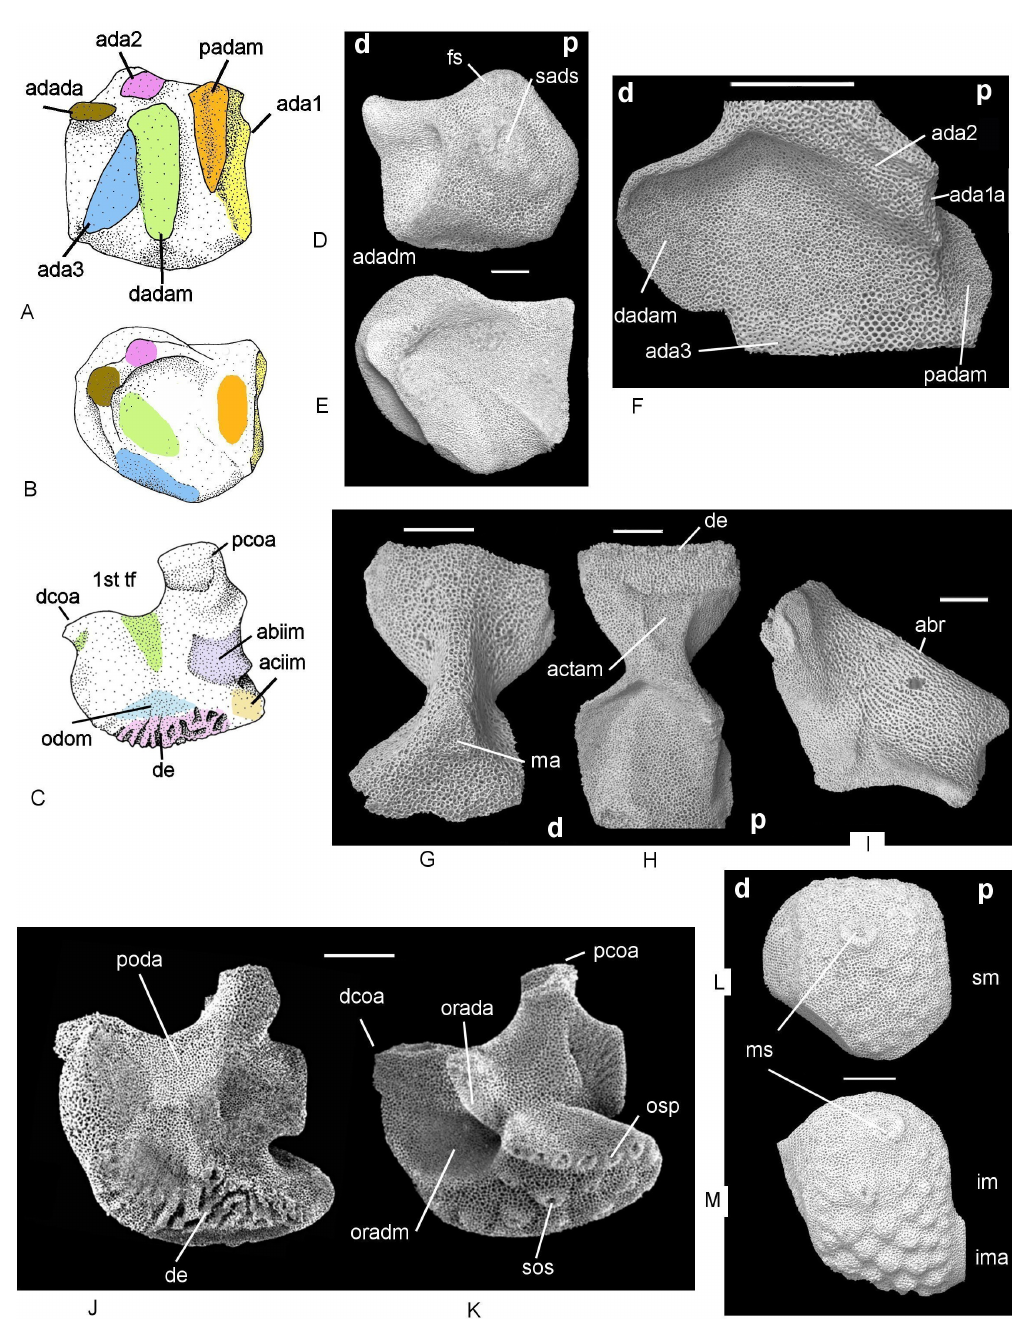
Fig. 3. A–C . Terminology used for adambulacrals and orals in the present paper. A . Actinal view of adambulacral of Luidia sp. — B–F . Benthopecten simplex (Perrier, 1881), Recent (NHMUK EE 13563). B . Abactinal view of adambulacral. C . Interradial view of oral ossicle. D–E . Adambulacral in actinal (D) and abactinal (E) views. F . Base of ambulacral in actinal view. — G–I . Cheiraster gazellae Studer, 1883, Recent (A.S. Gale collection, unregistered), ambulacral ossicles in abactinal (G), actinal (H) and proximal (I) views; note raised abactinal ridge (abr) and inferomarginal articulation (ma). — J–M . Pontaster tenuispinus (von Düben & Koren, 1846), Recent (A.S. Gale collection, unregistered). J–K . Oral ossicle in radial (K) and interradial (J) aspects. L–M . Supero- and inferomarginal pair. Abbreviations: d = distal; p = proximal; see Material and methods; after Gale 2011a: figs 10, 16. Scale bars: 1